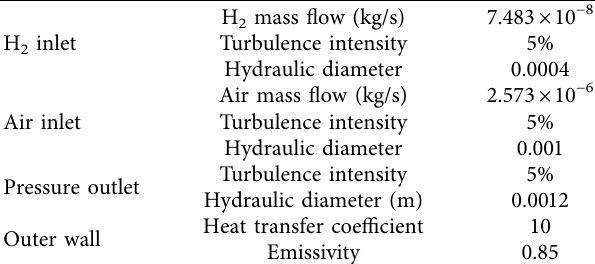
Table 3: Model boundary